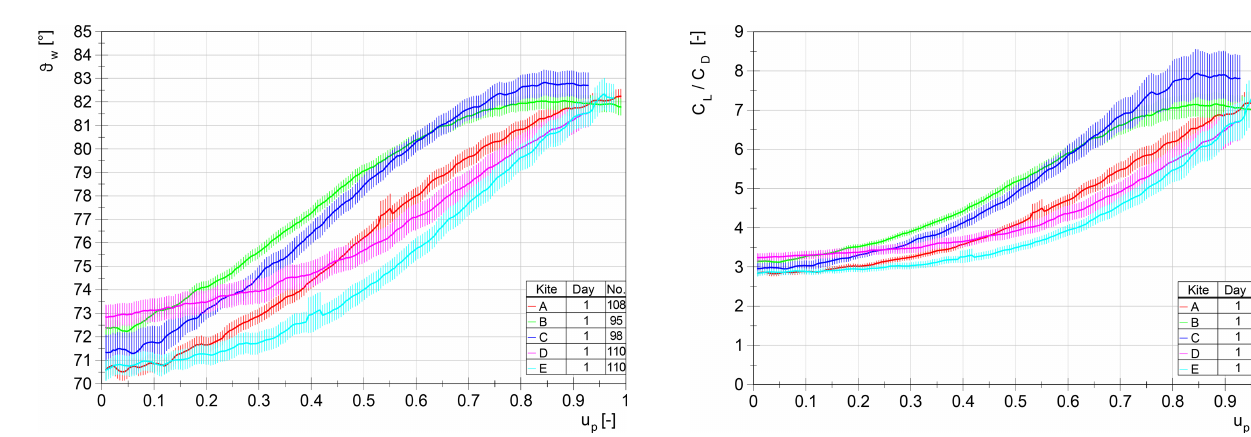
Figure 13. Elevation angle with resulting error ( P = 95%). Figure 14. Aerodynamic efficiency (lift-to-drag ratio) with result- ing error ( P = 95%).